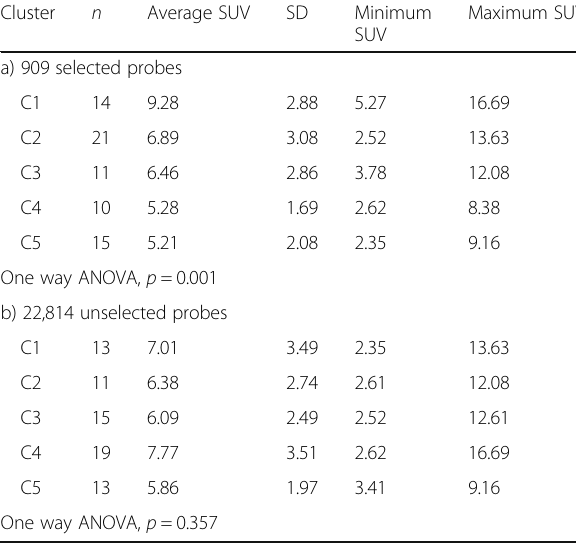
Table 3 SUVmean35 (SUV) averages, standard deviations (SD), minimum and maximum values of the samples of each of the five clusters identified using the indicated number of probes in the training set Cluster